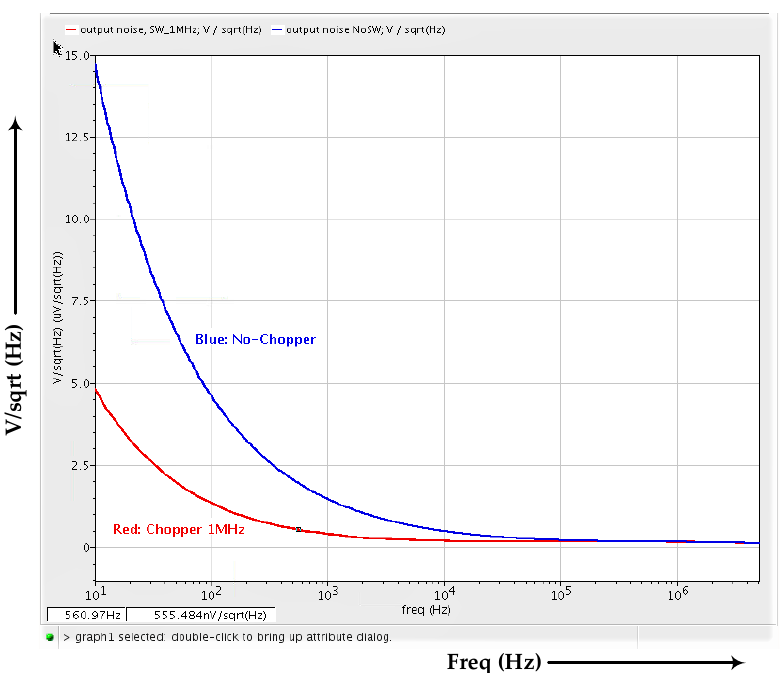
Figure 16. Noise comparisons between chopped and non-chopped bandgaps. The graph shows a reduction in flicker noise from 181.3 to 10.26 mV/sqrt(Hz) at 100 KHz with a filter.